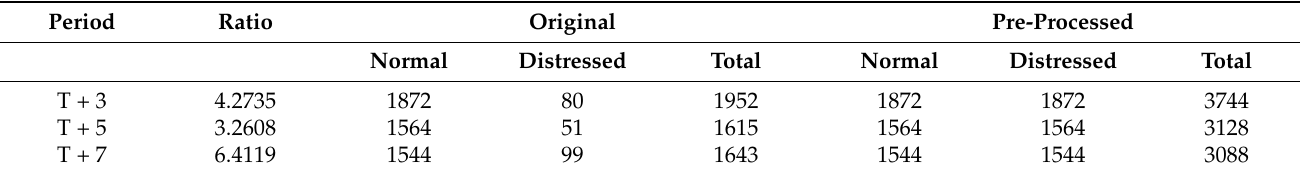
Table 3. Number of Data Before and After the Application of SMOTE